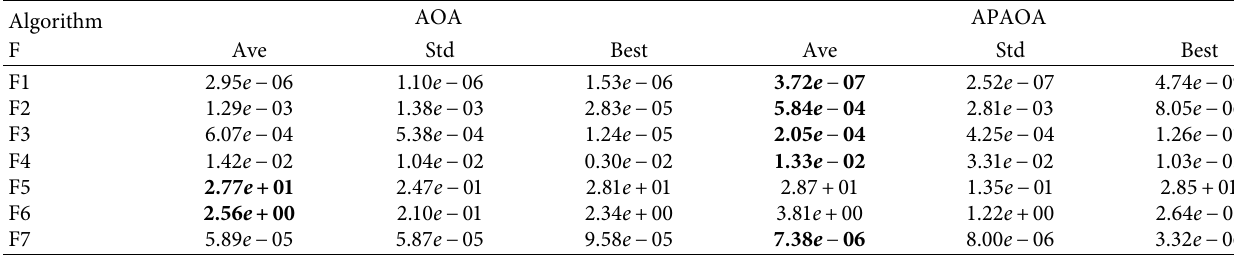
Table 4: Unimodal function test on 30D.